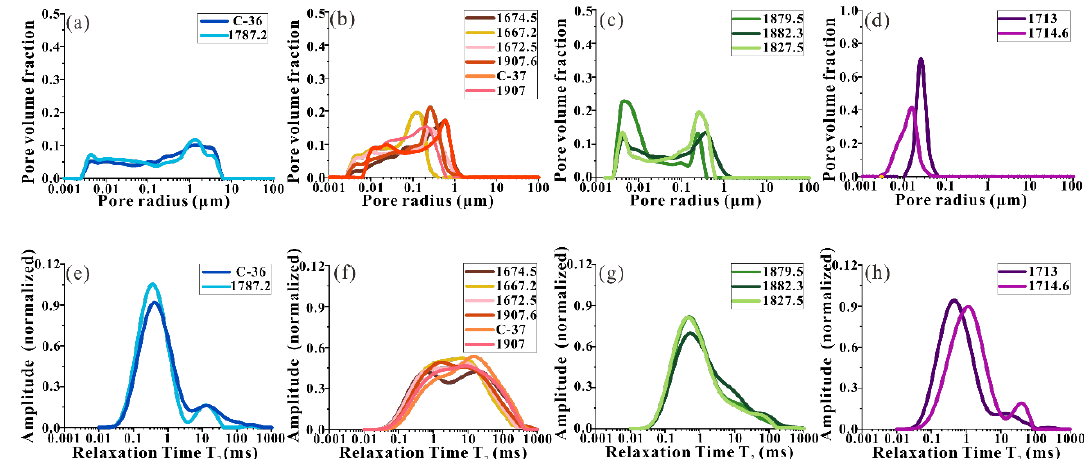
Figure 6. PSD obtained from the HPMI and NMR experiments of four typical lithofacies. ( a )–( d ) PSD derived from HPMI for authigenic clay mineral facies (ACMF), quartz cemented-dissolution facies (QCDF), carbonate cemented facies (CCF), and matrix-caused tightly compacted facies (MCTF) ( e )– ( h ) PSD derived from NMR for the ACMF, QCDF, CCF, and MCTF.